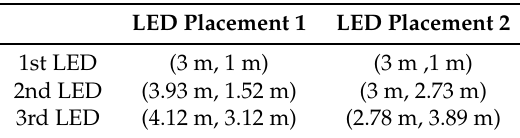
Table 1. Position of each LED placement.